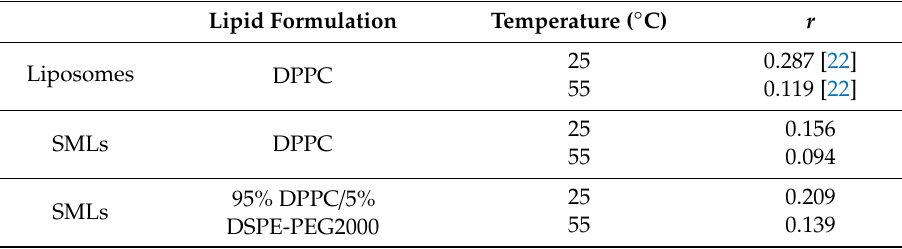
Table 7. Steady-state fluorescence anisotropy ( r ) values for curcumin at 25 ◦ C and 55 ◦ C in solid magnetoliposomes containing Ca 0.25 Mg 0.75 Fe 2 O 4 . Values for curcumin in DPPC liposomes are also shown for